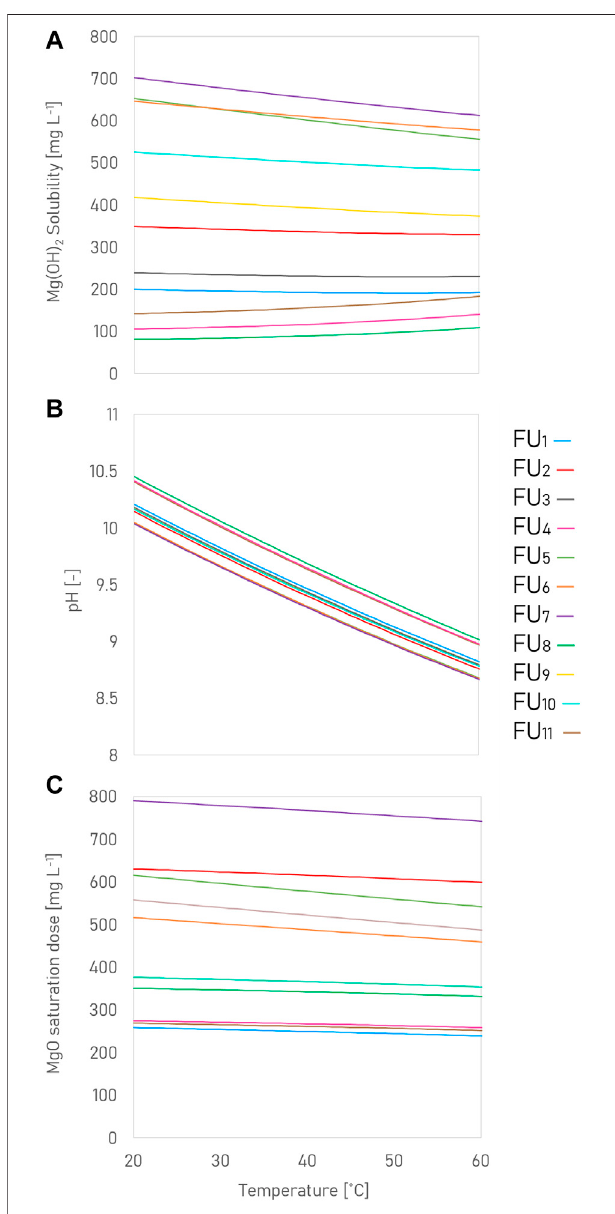
FIGURE3| Thesimulated (A) solubilityofMg(OH) 2 , (B) pHand (C) MgO dosage needed to saturate fresh human urine at different temperatures and for different urine compositions. The compositions are described in detail in Table 1